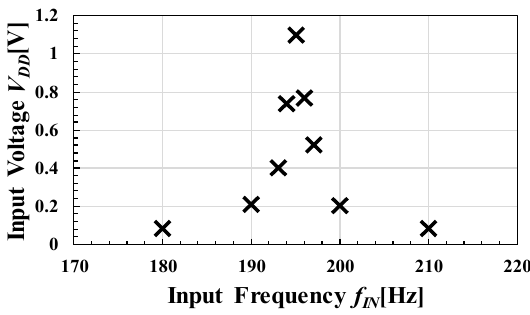
Figure 19. Measured V DD as a function of α ( R L = ∞ , α = 0.5 G).